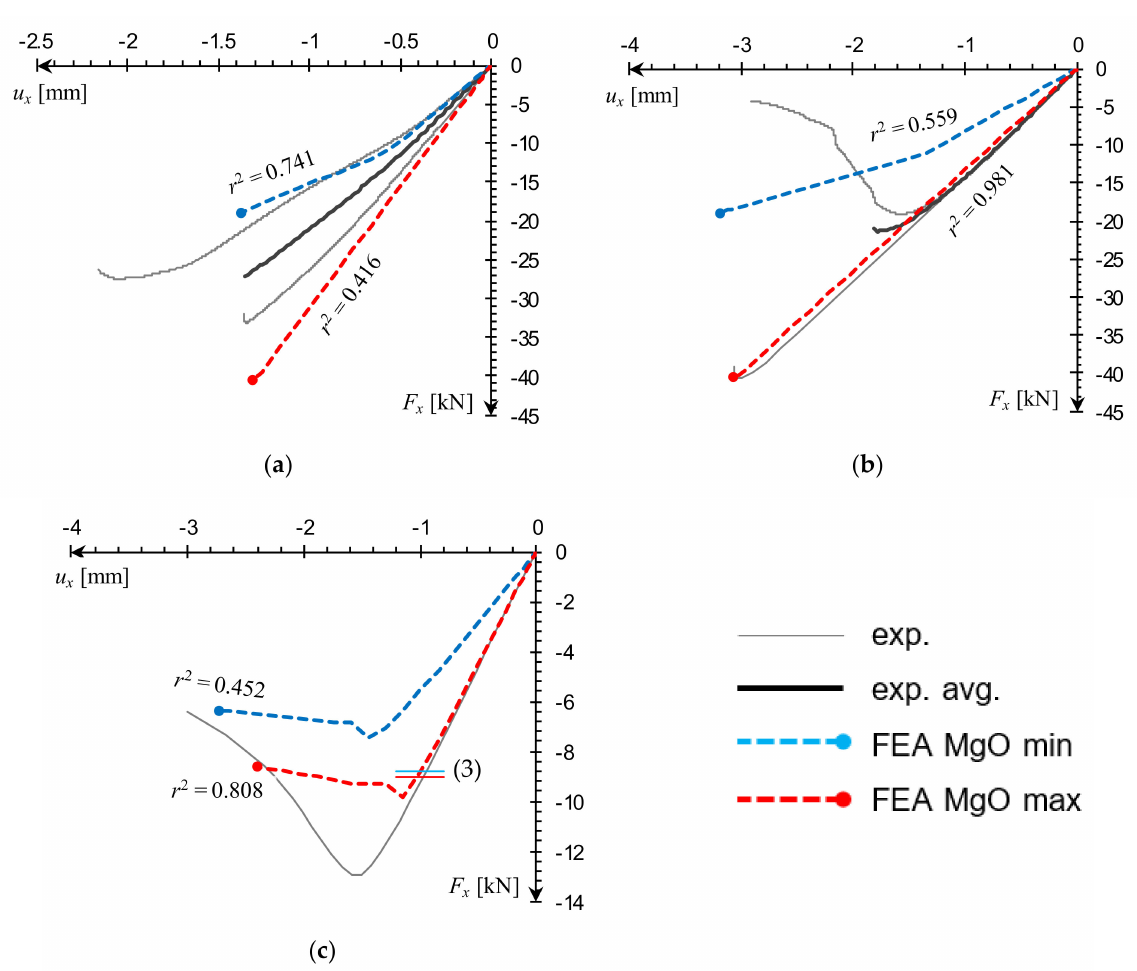
Figure 11. Comparison of small-scale sample compression F x ( u x ) curves obtained from FEA against experimental data for ( a ) L1, ( b ) L2, ( c )